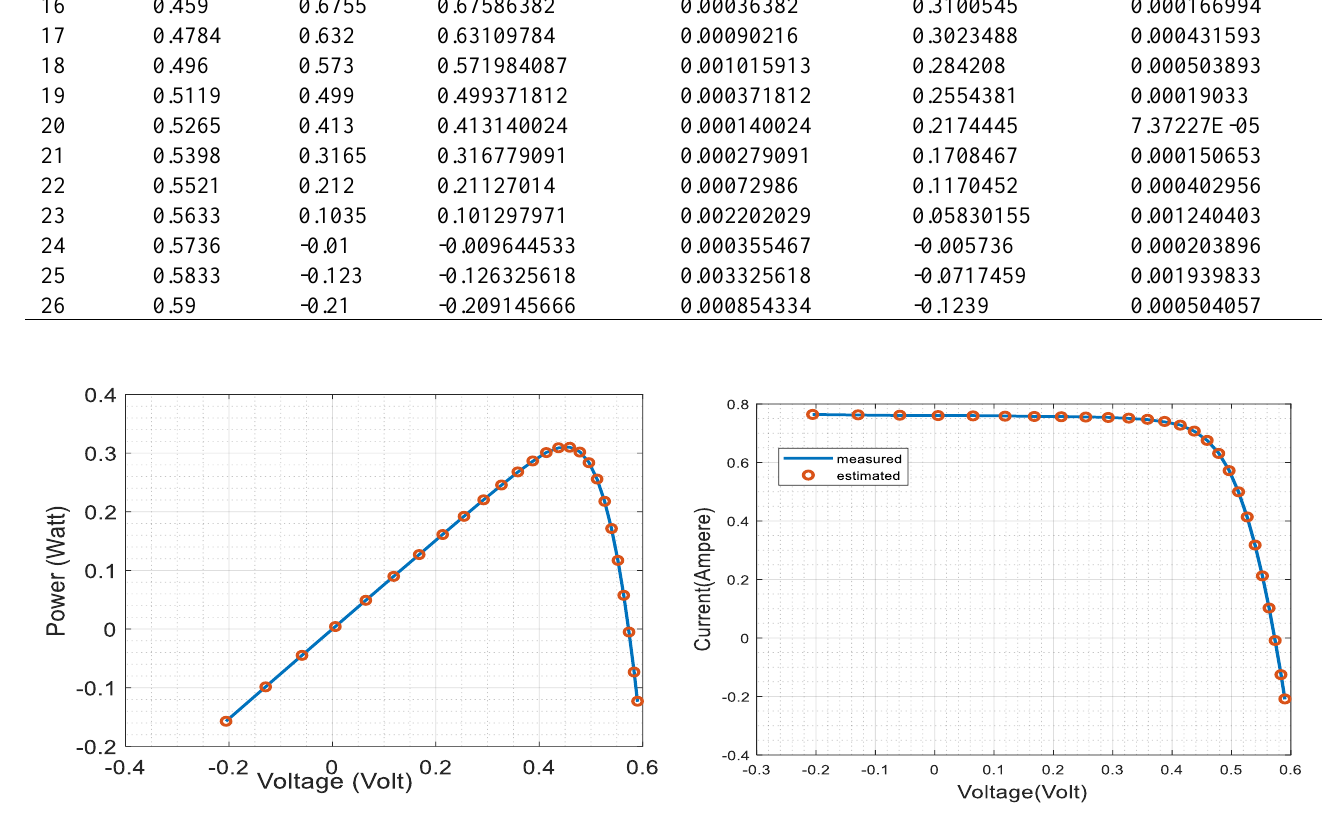
Fig. 3. P-V and I-V curves for Single Diode Model based on parameters estimated from PSO